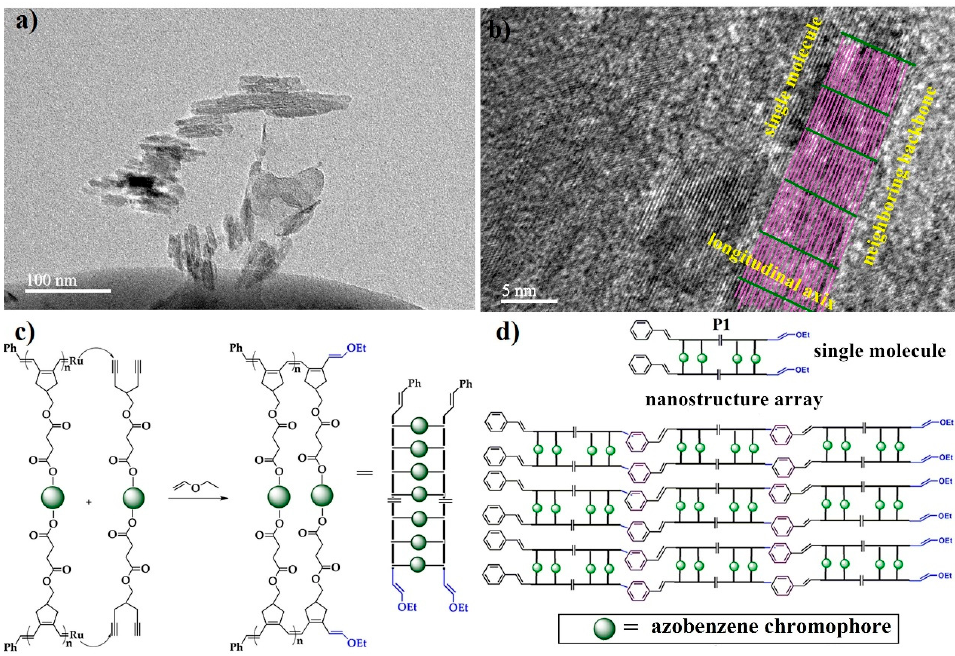
Figure 2. ( a ) TEM image ( a , b ) and the schematic illustration of double-stranded P1 ( c , d ).